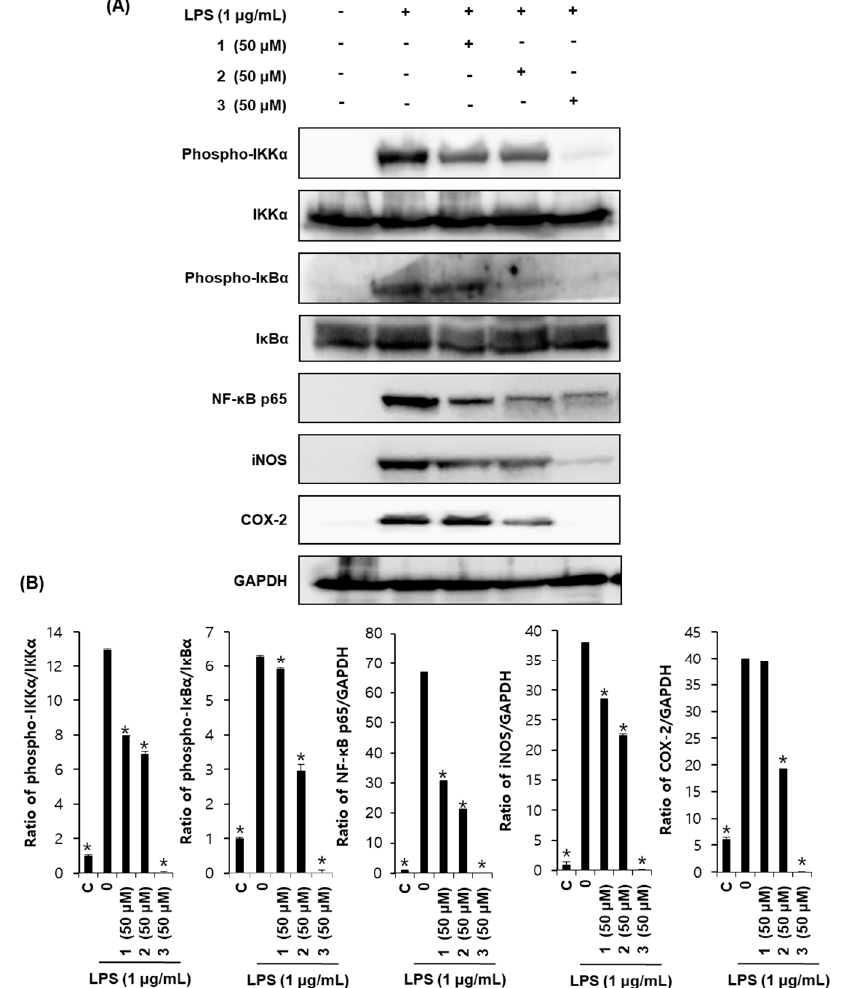
Figure 4. Effects of compounds 1 , 2 and 3 on the expression of proteins associated with inhibition of NF- κ B in LPS-stimulated RAW264.7 mouse macrophages ( A ). Each bar graph presents the densitometric quantification of western blot bands ( B ). * p < 0.05 compared to the LPS-treated value.